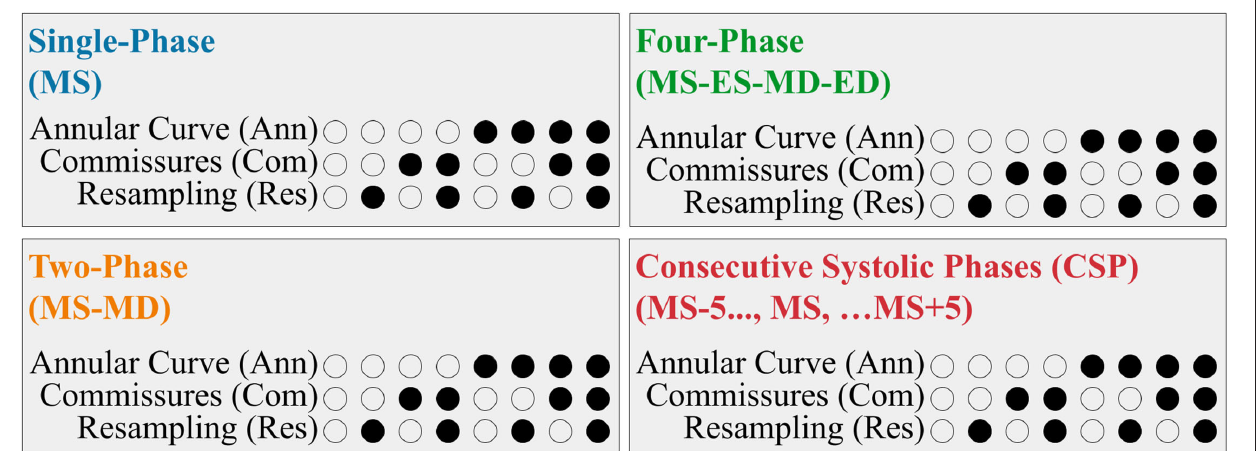
FIGURE 4 | Summary of the FCN Input Variants. Each 3DE input (Single-Phase, Two-Phase, Four-Phase, and CSP) was performed with eight permutations created by the optional addition of the resampling, annular curve input, and commissural landmarks input, as depicted in the binary combination of circles (unfilled: no; filled: